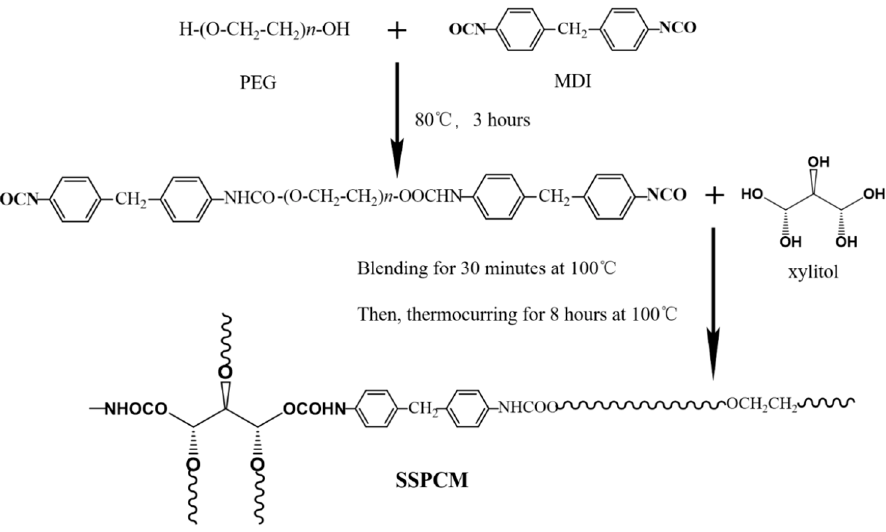
Figure 10. Diagram of polymerization mechanism [80].